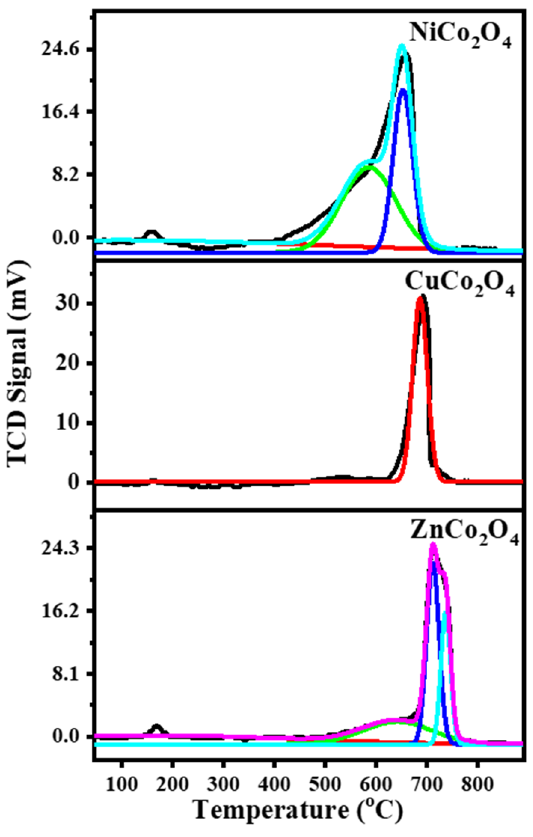
Figure 4. CO 2 -TPD patterns for NiCo 2 O 4 , CuCo 2 O 4 and ZnCo 2 O 4 samples. Table 2. Data obtained from CO 2 -TPD measurements for the investigated samples.